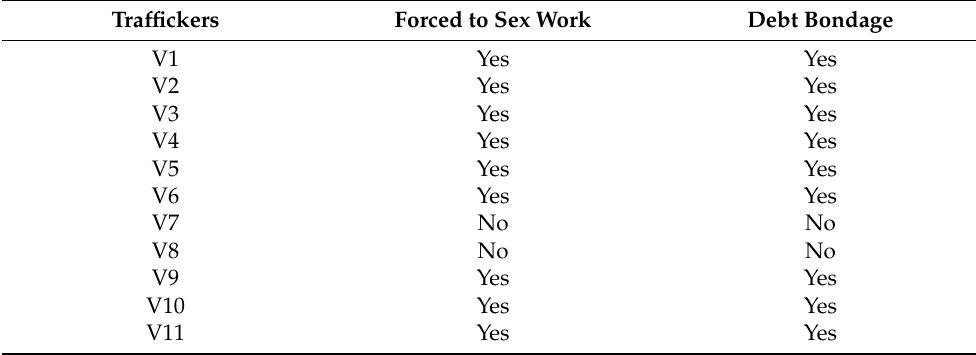
Table 3. The traffickers pointed out by the respondents. Traffickers Forced to Sex Work Debt